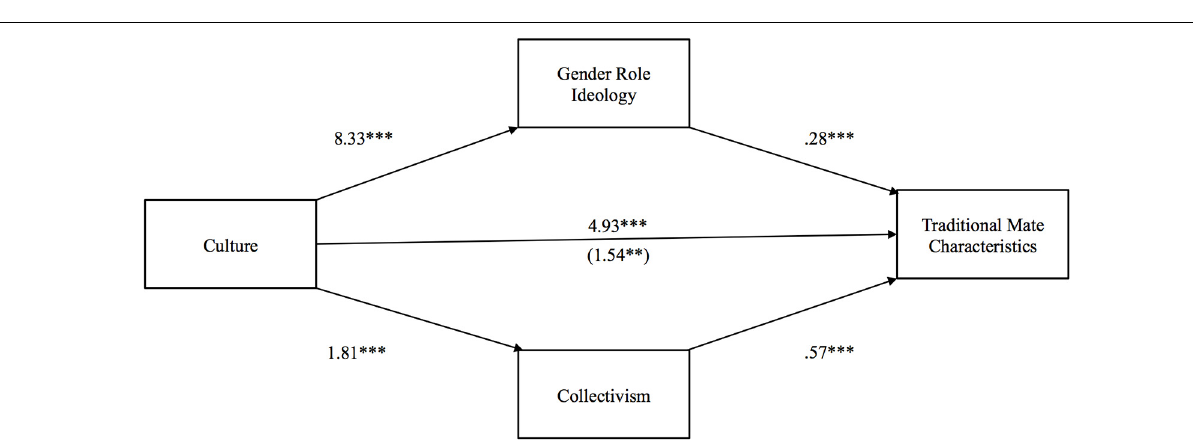
FIGURE 2 | Indirect effect of culture on preferences for traditional mate characteristics through gender role ideology and collectivism. The value in parentheses represents the direct effect, and the value directly above is the total effect. ∗ p < 0 . 05, ∗∗ p < 0 . 01, ∗∗∗ p < 0 .